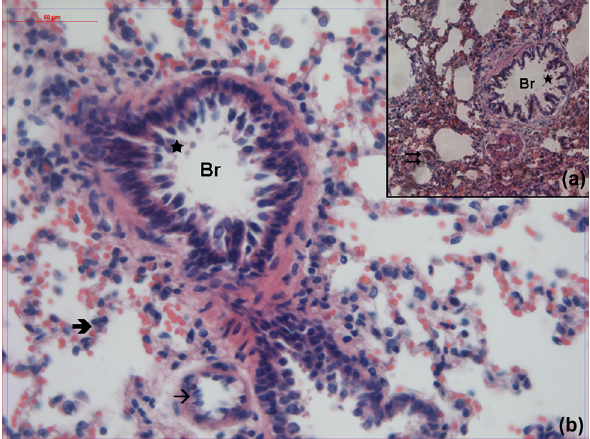
Figure 3: Hematoxylin – eosin - stained lung samples obtained from the propofol - treated group. Br: bronchioles, (cid:2) : alveoli, (cid:3) : inter - alveolar septa, (cid:2) : cell debris, → : vessel ( hematoxylin – eosin, A: × 100, B: × 400 ) .